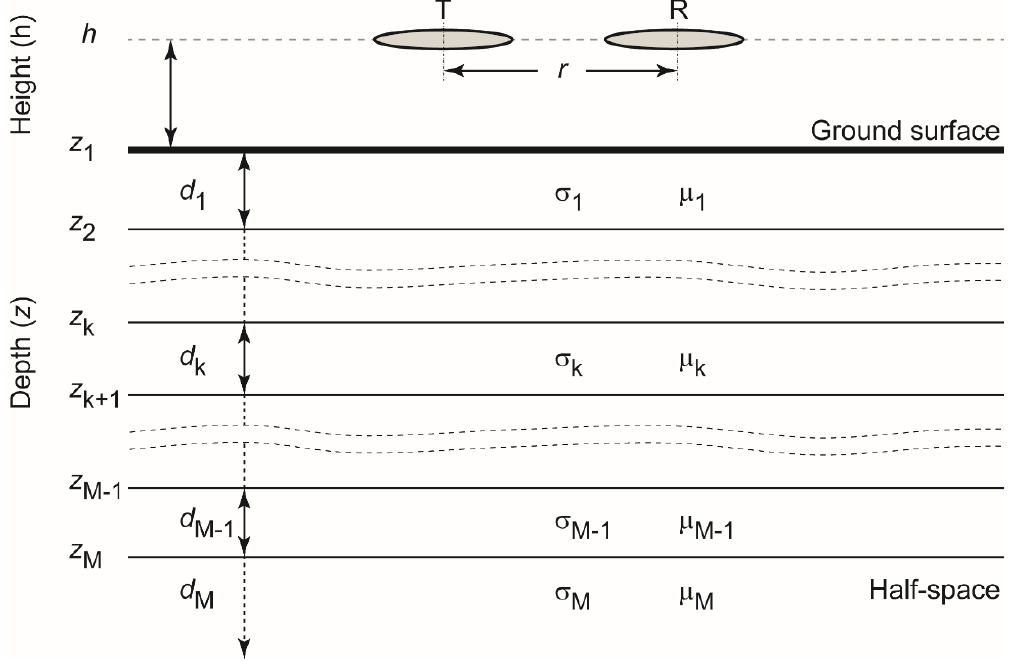
Figure 5. Schematic representation of the subsoil discretization and parameterization along with the coils of the measuring device above the